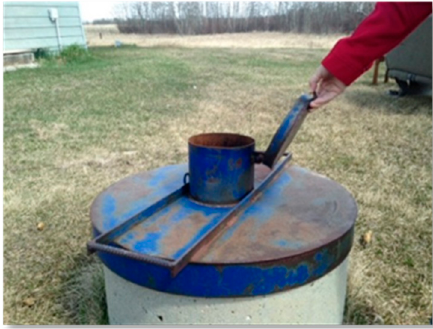
Figure 3. Cistern cap, intact but unlocked. Photo credit: R. Patrick.